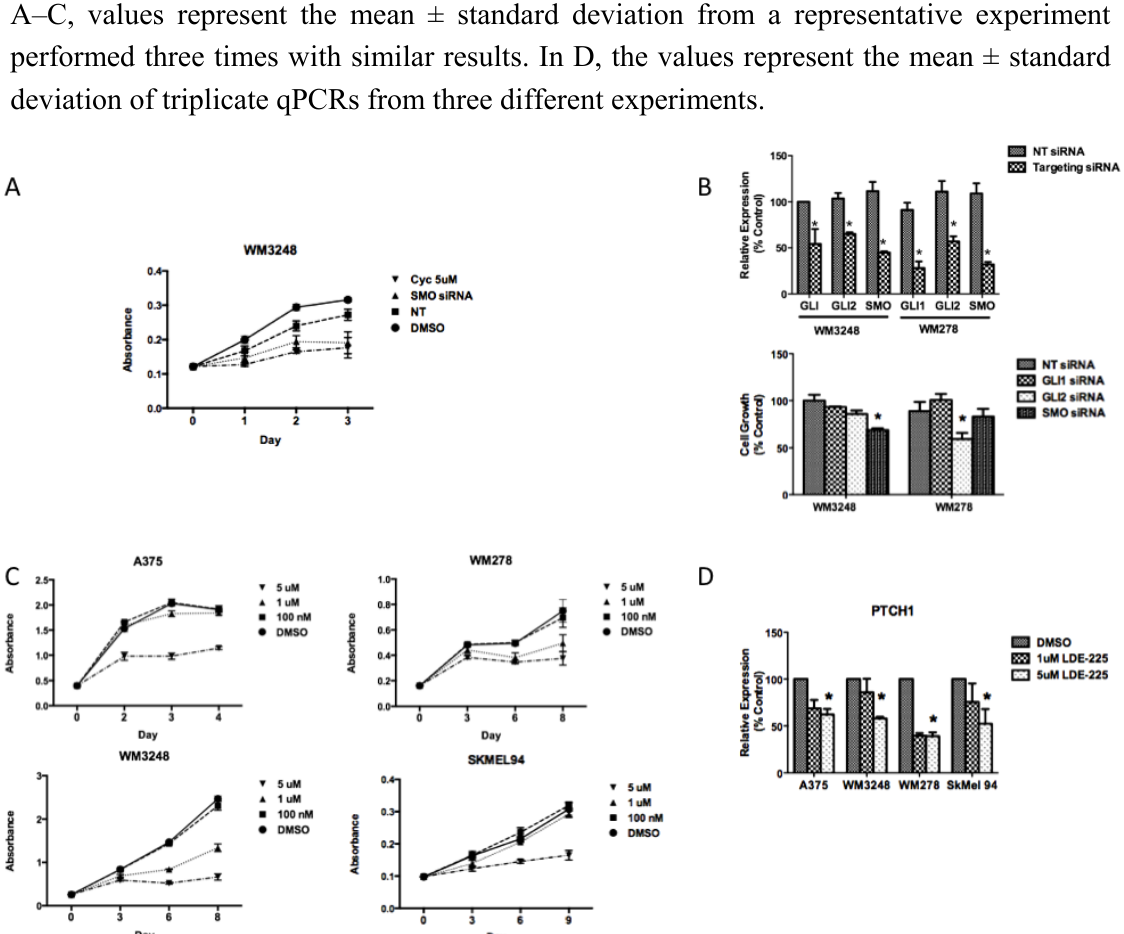
Figure 4. Smoothened inhibition has antiproliferative effects in melanoma in vitro